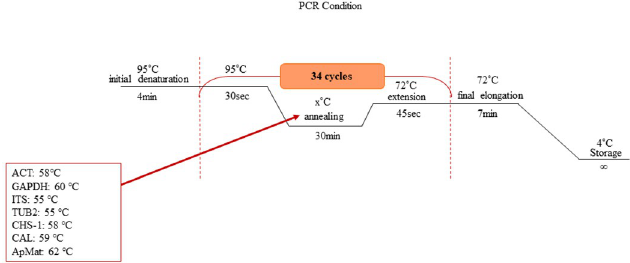
Fig 2. PCR reaction conditions. Annealing temperature of corresponding gene is given in the